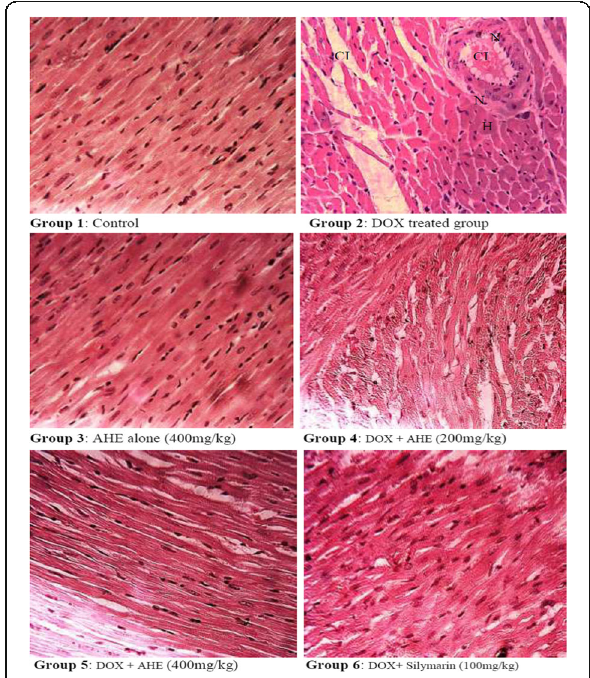
Fig. 2 Histopathological changes induced by Doxorubicin and protective effect of AHE in rat heart (H&E staining, magnification 40X). Group 1: Cardiac section from control rats showing normal morphology. Group 2: cardiac sections from DOX-treated rats reveal